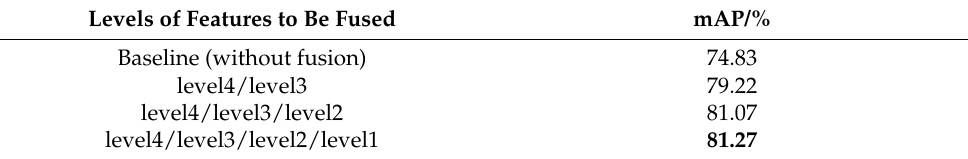
Table 4. Effect of level selection of features to be fused on model performance. Levels of Features to Be